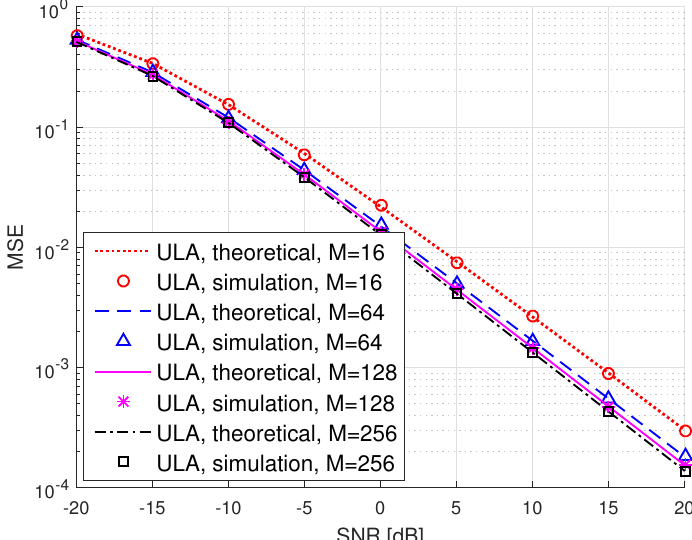
Figure 4. MSE vs. SNR in dB for the ULA topology, U = 10 UEs, α A ( AS ) = 5, with different numbers of base station antennas.